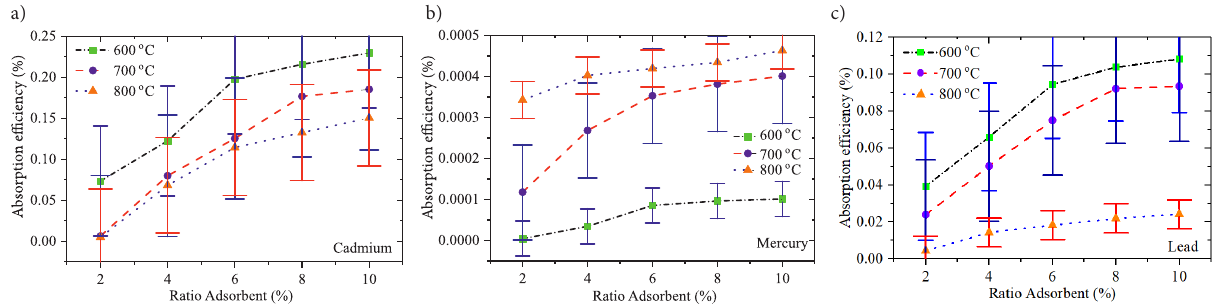
Figure 6. Efficiency absorption Cd, Hg, and Pb metal for ratio at different temperatures